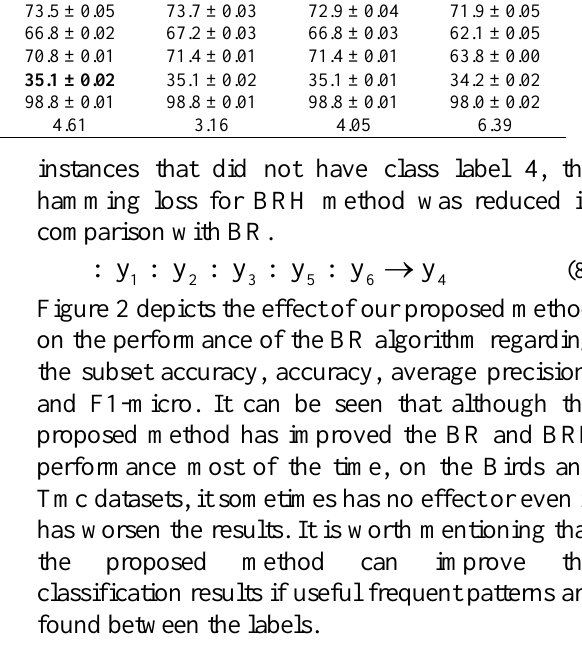
proposed method can the classification results if useful frequent patterns are found between the labels.